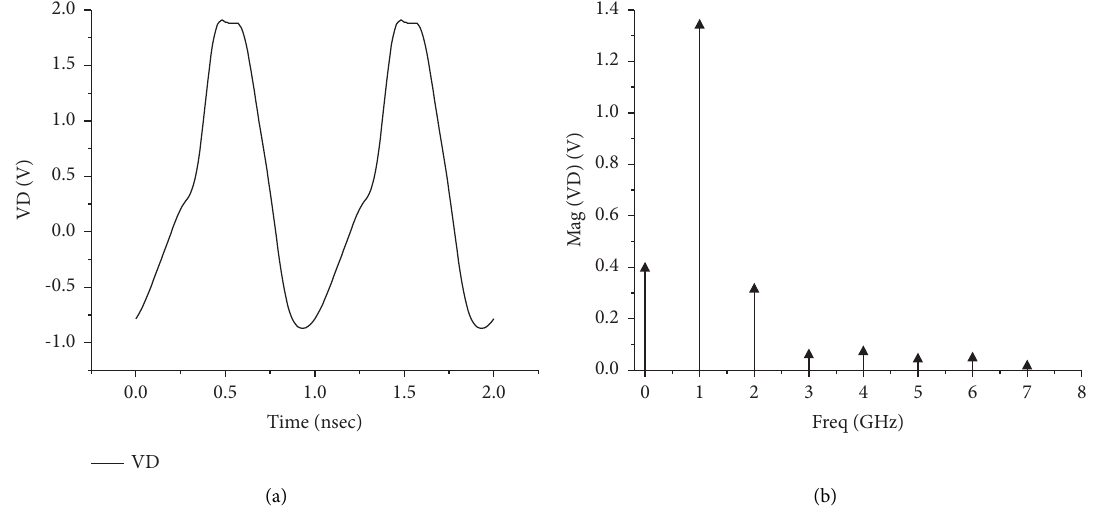
Figure 9: Waveform of VD test point when the waveform of VR is quadruple period: (a) waveform of time domain and (b) magnitude of the frequency domain.